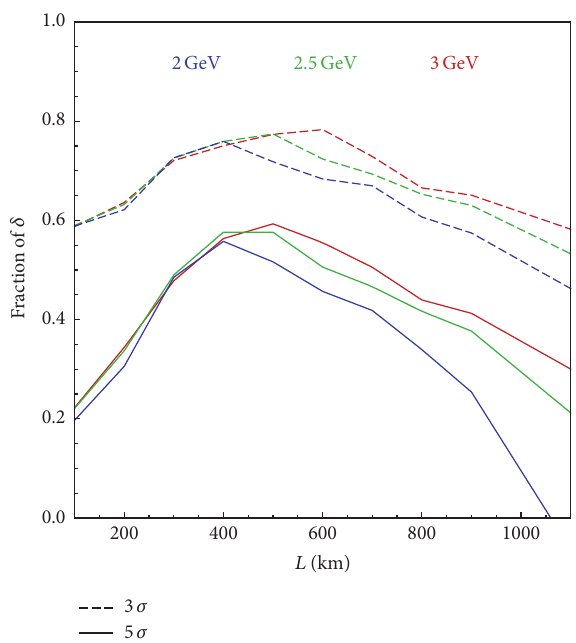
Figure 8: The curves show the fraction of the total range of possible values for 𝛿 CP for which CP violation can be discovered with 5𝜎 and 3𝜎 significance level, respectively, as a function of the distance 𝐿 between the accelerator and the detector (the baseline), with 𝐿 ranging from 100km to 1000km (horizontal axis) for three different proton beam energies 2.0, 2.5, and 3.0 GeV (blue, green, and red curves) and for a value of the mixing angle 𝜃 13 = 8.73 ∘ . The systematic errors used to produce these plots are those listed in the left column (SB Def.) of Table 3.